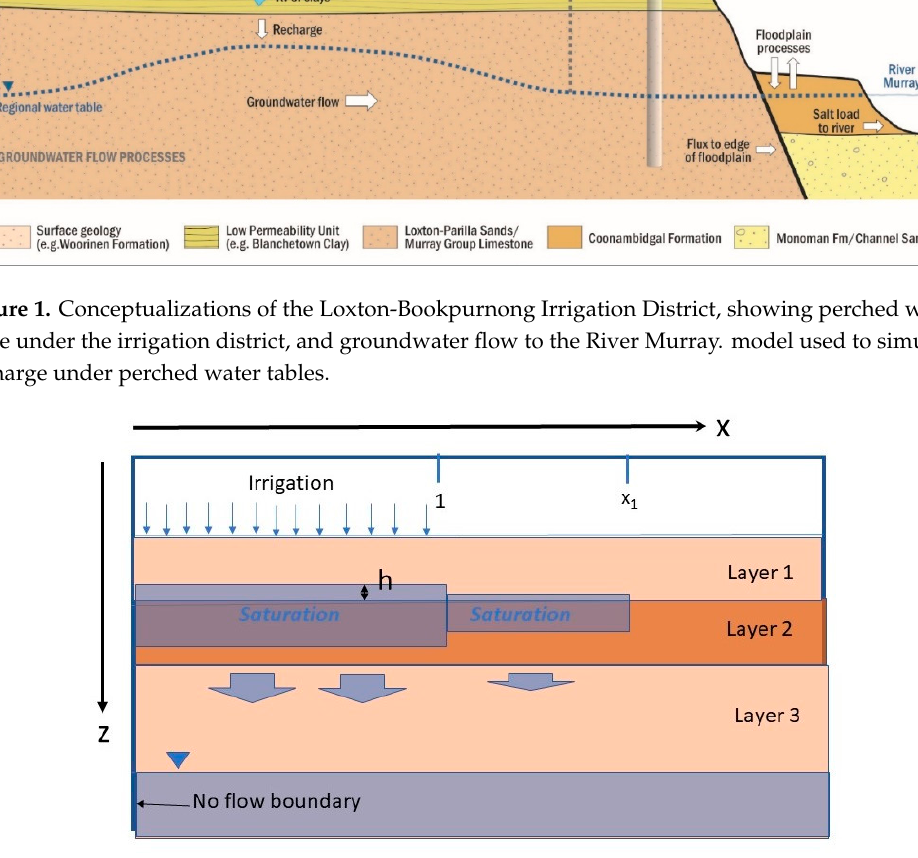
Figure 1. Conceptualizations of the Loxton-Bookpurnong Irrigation District, showing perched water table under the irrigation district, and groundwater flow to the River Murray. model used to simulate recharge under perched water tables.